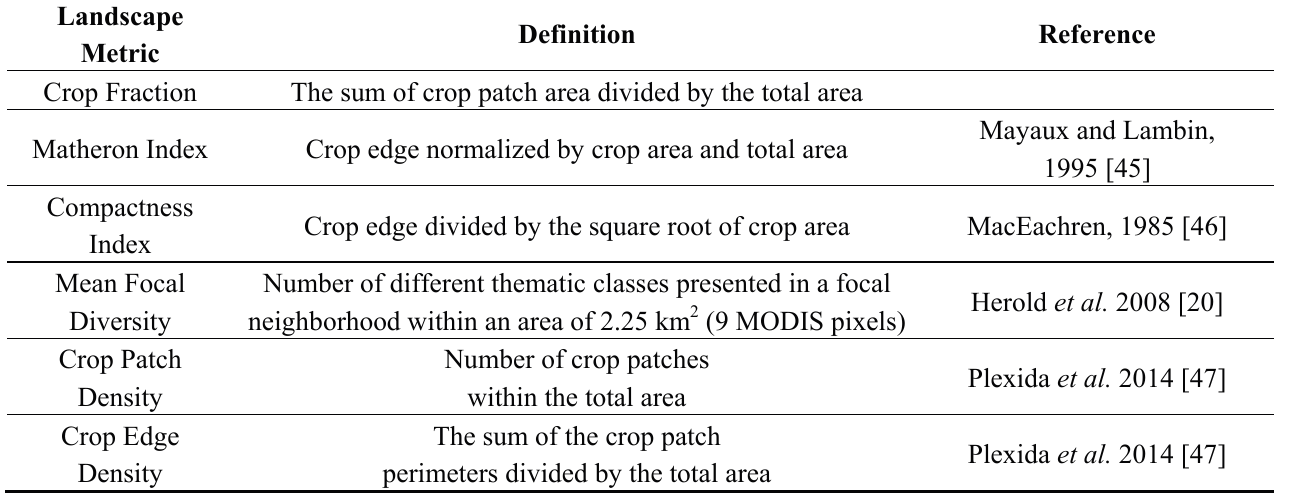
Table 1. List of the landscape metrics used to describe the agricultural landscape fragmentation. Total area = 25 km 2 (100 MODIS